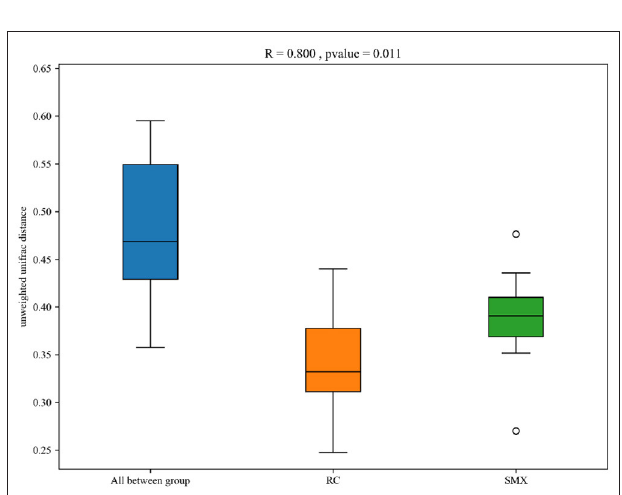
FIGURE 6 | Box plot of inter-group and intra-group beta distance [analysis of similarity (ANOSIM)]. R -value range (0–1): R -values close to 0 represent no significant differences between inter-group and intra-group; R-values close to 1 show that inter-group differences are greater than intra-group differences. Boxes represent the interquartile range (IQR; between the 25th and 75th percentiles); the horizontal line inside the box defines the median, and outliers > 1.5 and < 3 times the